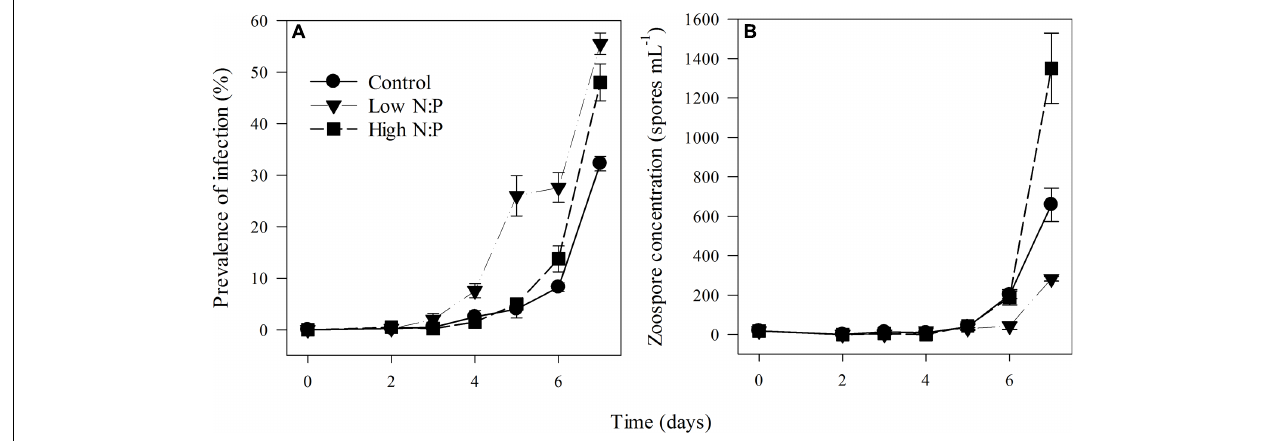
FIGURE 3 | Prevalence of infection (A) and zoospore concentration (B) in the control, low N:P and high N:P treatments. Symbols represent mean ± standard error ( n =